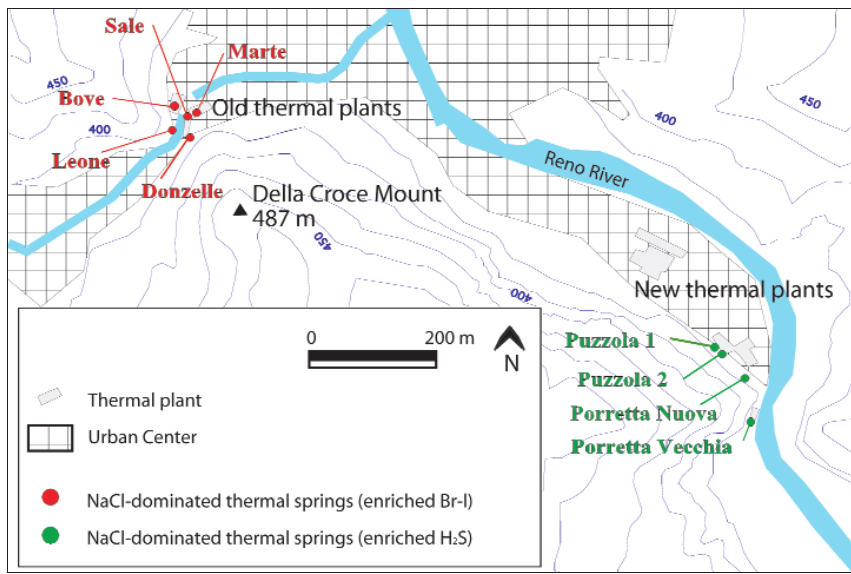
Fig. 2. Sampling sites at Porretta thermal area. The thermal waters are close to the old and new thermal plants respectively located on the Rio Maggiore and Reno